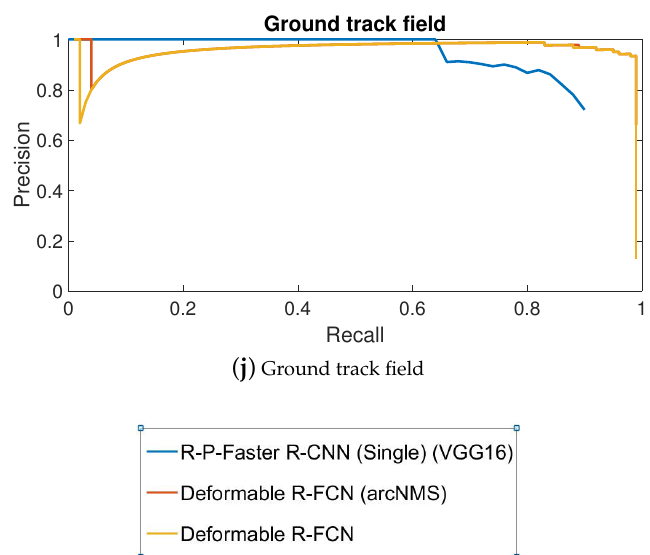
Figure 8. PRCs (Precision Recall Curves) of top three object detection approaches in mean AP. PRCs of objects including airplanes, ships, bridges, storage tanks, baseball diamonds, tennis courts, basketball courts, ground track fields are shown in ( a – j ), respectively.